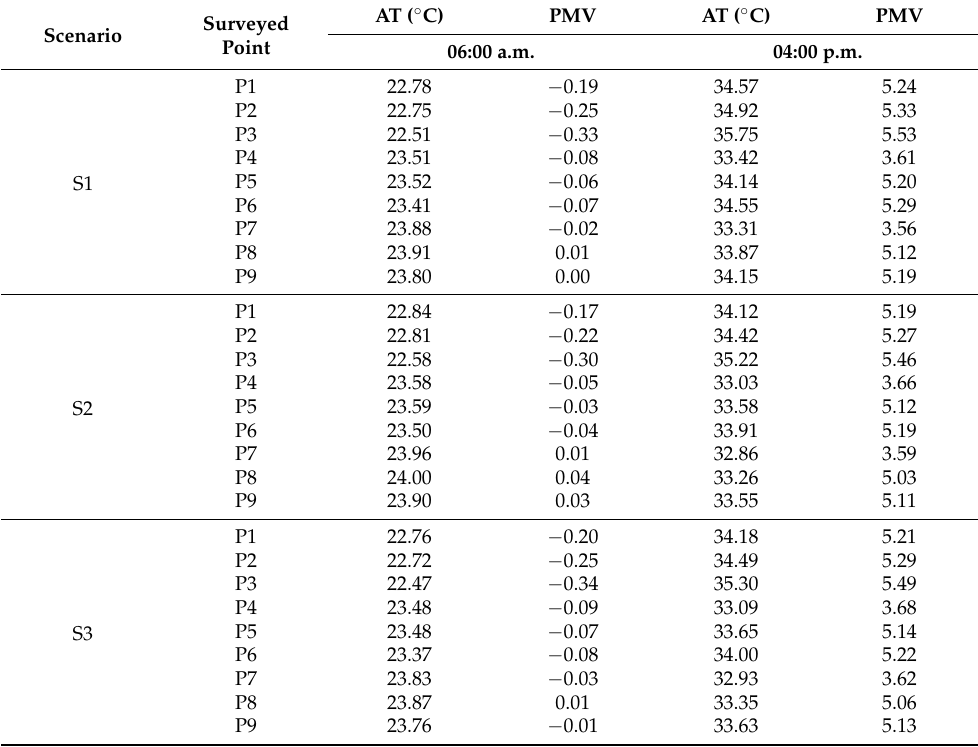
Table 4. AT and PMV values at 06:00 a.m. and 04:00 p.m.